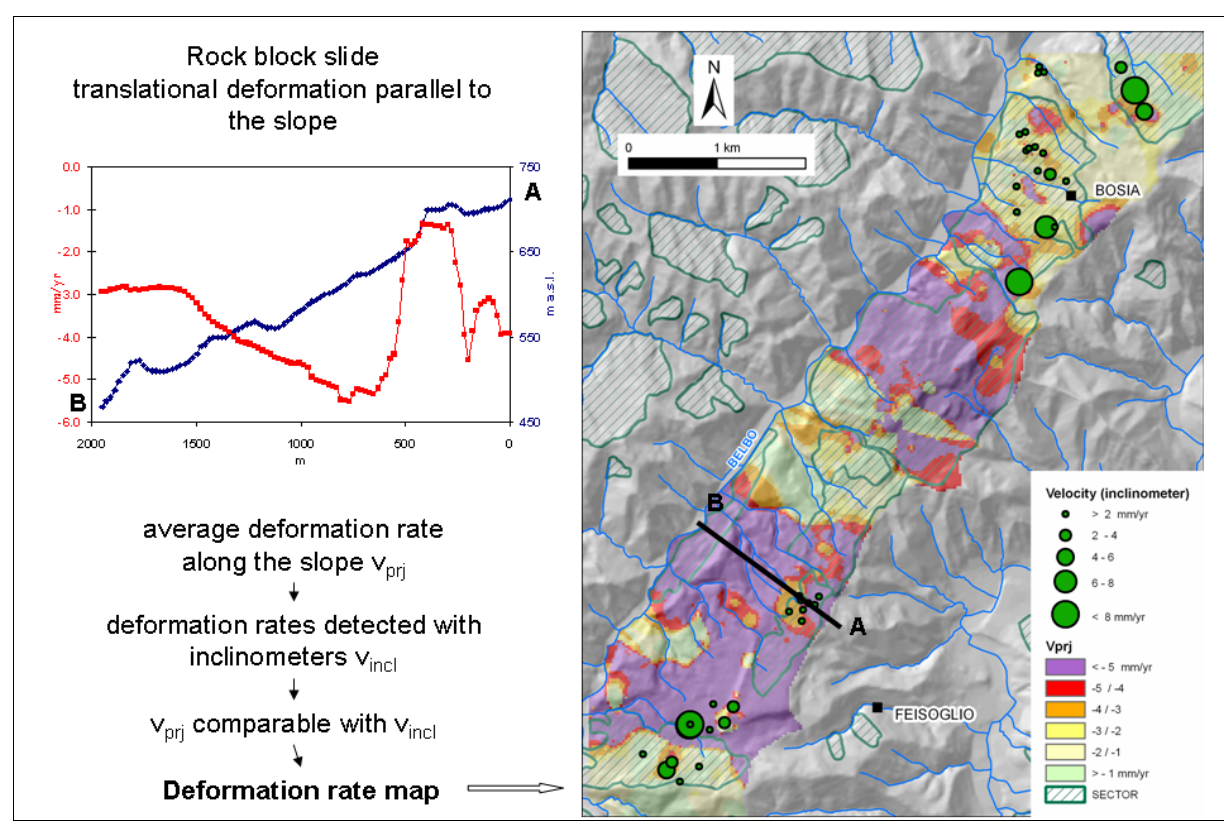
Figure 10. Comparison between the velocity measured by the inclinometers and the velocity of PS along the